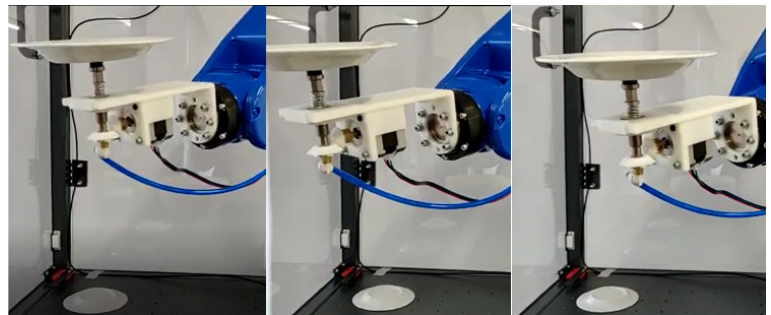
Figure 5. Simulation of the saucer’s diving. Source: (Own).